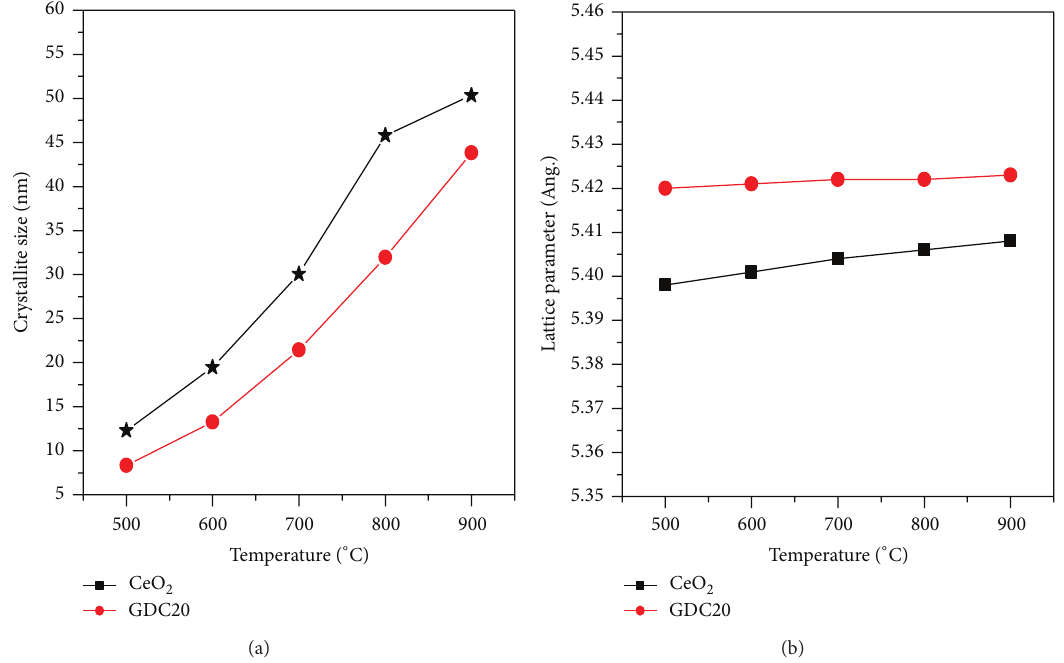
Figure 7: (a) The average crystallite size of CeO 2 and GDC20 nanofibers, which were measured from X-ray line broadening and (b) the lattice parameter of CeO 2 and GDC20 nanofibers calcined at 500–900 ∘ C for 8 h in air.